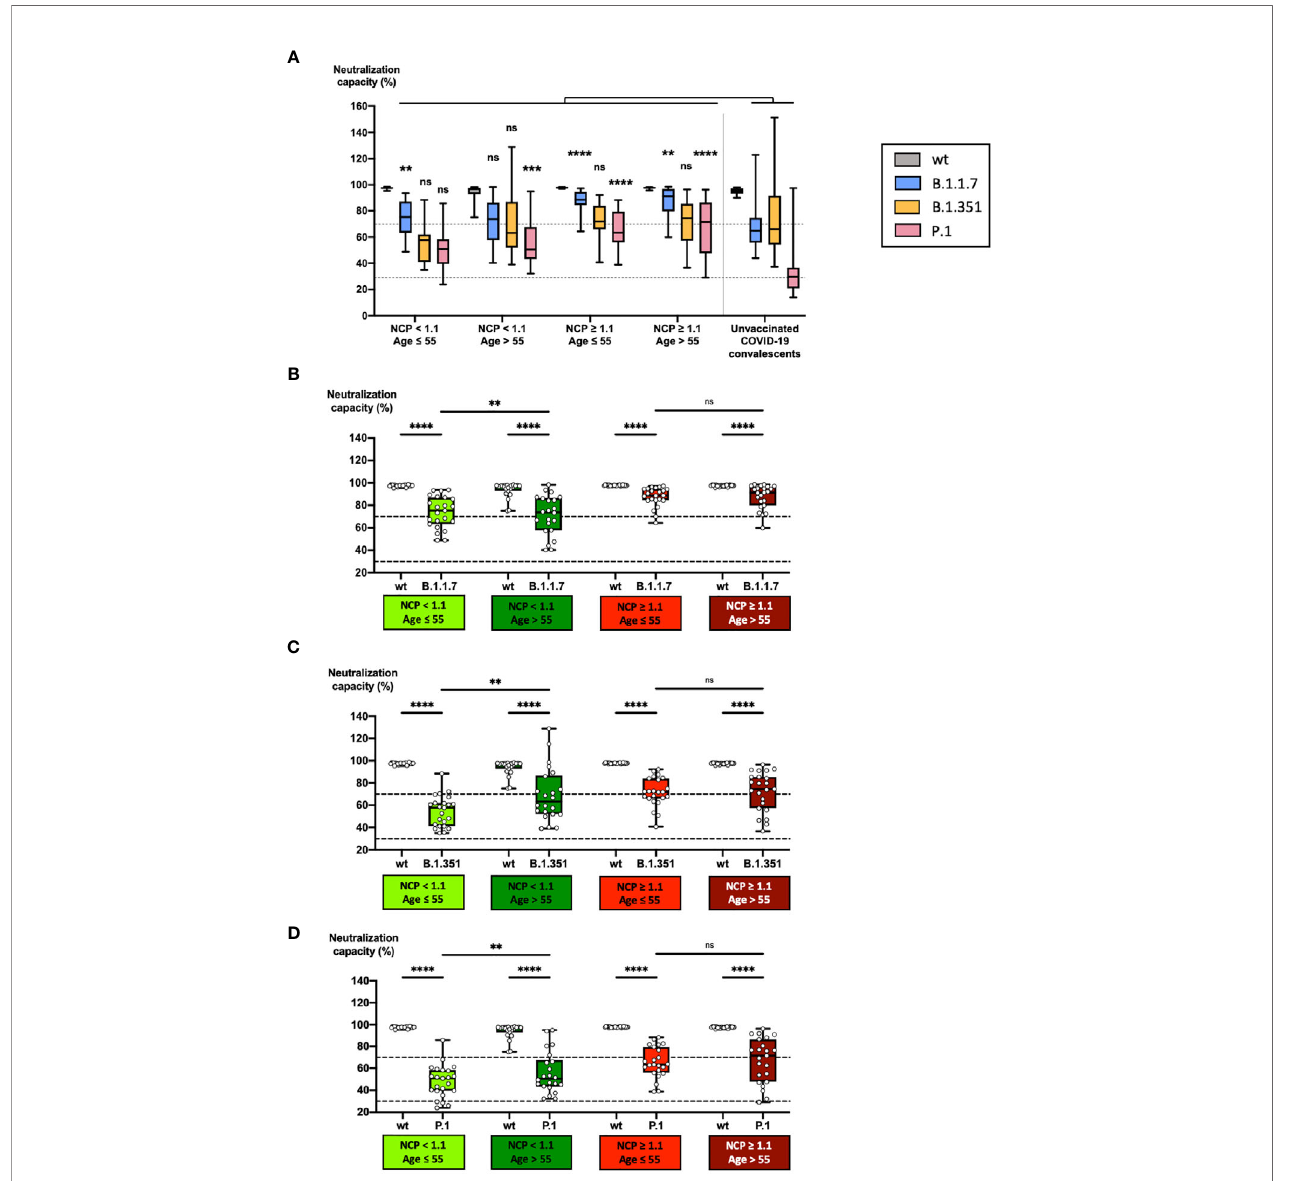
FIGURE 5 | Impact of age and COVID-19 convalescence on neutralizing capacity against variants of concern after vaccination. Serum samples from 23 subjects with anti-NCP IgG OD ratios < 1.1 and an age > 55, from 23 subjects with anti-NCP IgG OD ratios < 1.1 and an age ≤ 55, from 23 COVID-19-convalescent subjects with anti-NCP IgG OD ratios ≥ 1.1 and an age > 55 and from 23 OVID-19-convalescent subjects with anti-NCP IgG OD ratios ≥ 1.1 and an age ≤ 55 were collected 3 weeks after second vaccination with BNT162b2. Serum samples from 20 unvaccinated COVID-19-convalescent individuals, collected at a median time of 14 weeks after diagnosis served as control cohort. Samples were pre-diluted at 1:20 and analyzed for neutralization capacities against wildtype RBD and three RBD variants of concern. Box plots in panel (A) compare neutralization capacities in the four vaccinated cohorts with those in the unvaccinated COVID-19-convalescent cohort. Box blots in panels (B – D) show neutralization capacities against wildtype RBD and (B) the B.1.1.7 RBD variant, (C) the B.1.351 RBD variant and (D) the P.1 RBD variant. Dotted lines indicate cutoff values. Box central horizontal lines indicate medians, box borders represent IQR, whiskers indicate minima and maxima. Signi fi cance levels were **p < 0.005, ***p < 0.0005 and ****p < 0.00005. IQR, interquartile ranges; NCP, nucleocapsid; ns, not signi fi cant; OD, optical density; RBD, receptor-binding domain; wt:, wildtype